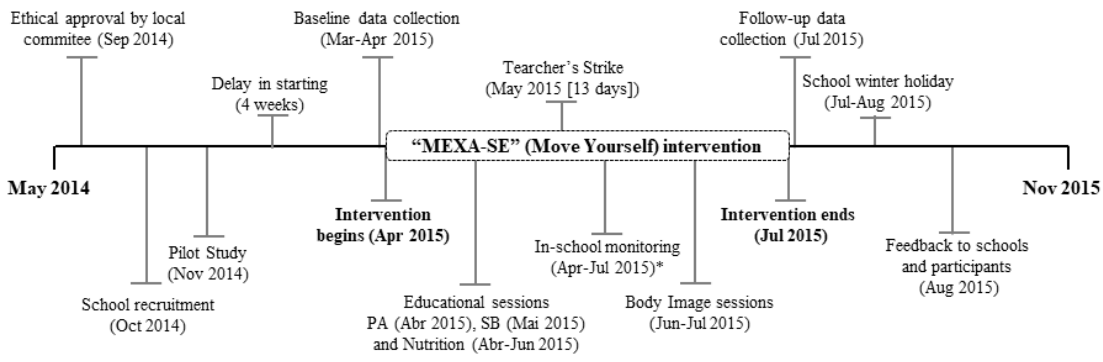
Figure 1. Timeline of the “ MEXA-SE ” intervention study. Note: PA: Physical activity; SB: Sedentary behaviour; *In-school monitoring comprised observations of physical education classes and school